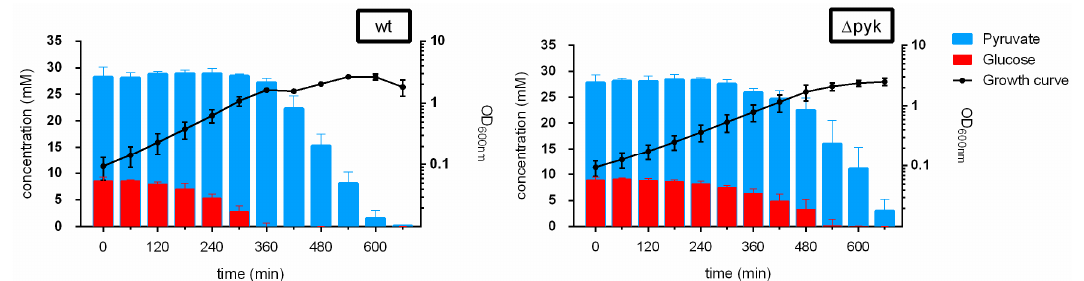
Figure 1. Growth curves and extracellular concentrations of glucose and pyruvate of Bacillus subtilis wild type (wt) and pyruvate kinase ( ∆ pyk) under M9GlcPyr medium cultivation. Black lines illustrate the growth curves, while colored columns represent the external concentration of glucose (red) and pyruvate (blue) at each hour. Data are represented as the mean values ± standard deviation (SD) of 4 biological replicates. M9GlcPyr—a mixture of glucose and pyruvate.